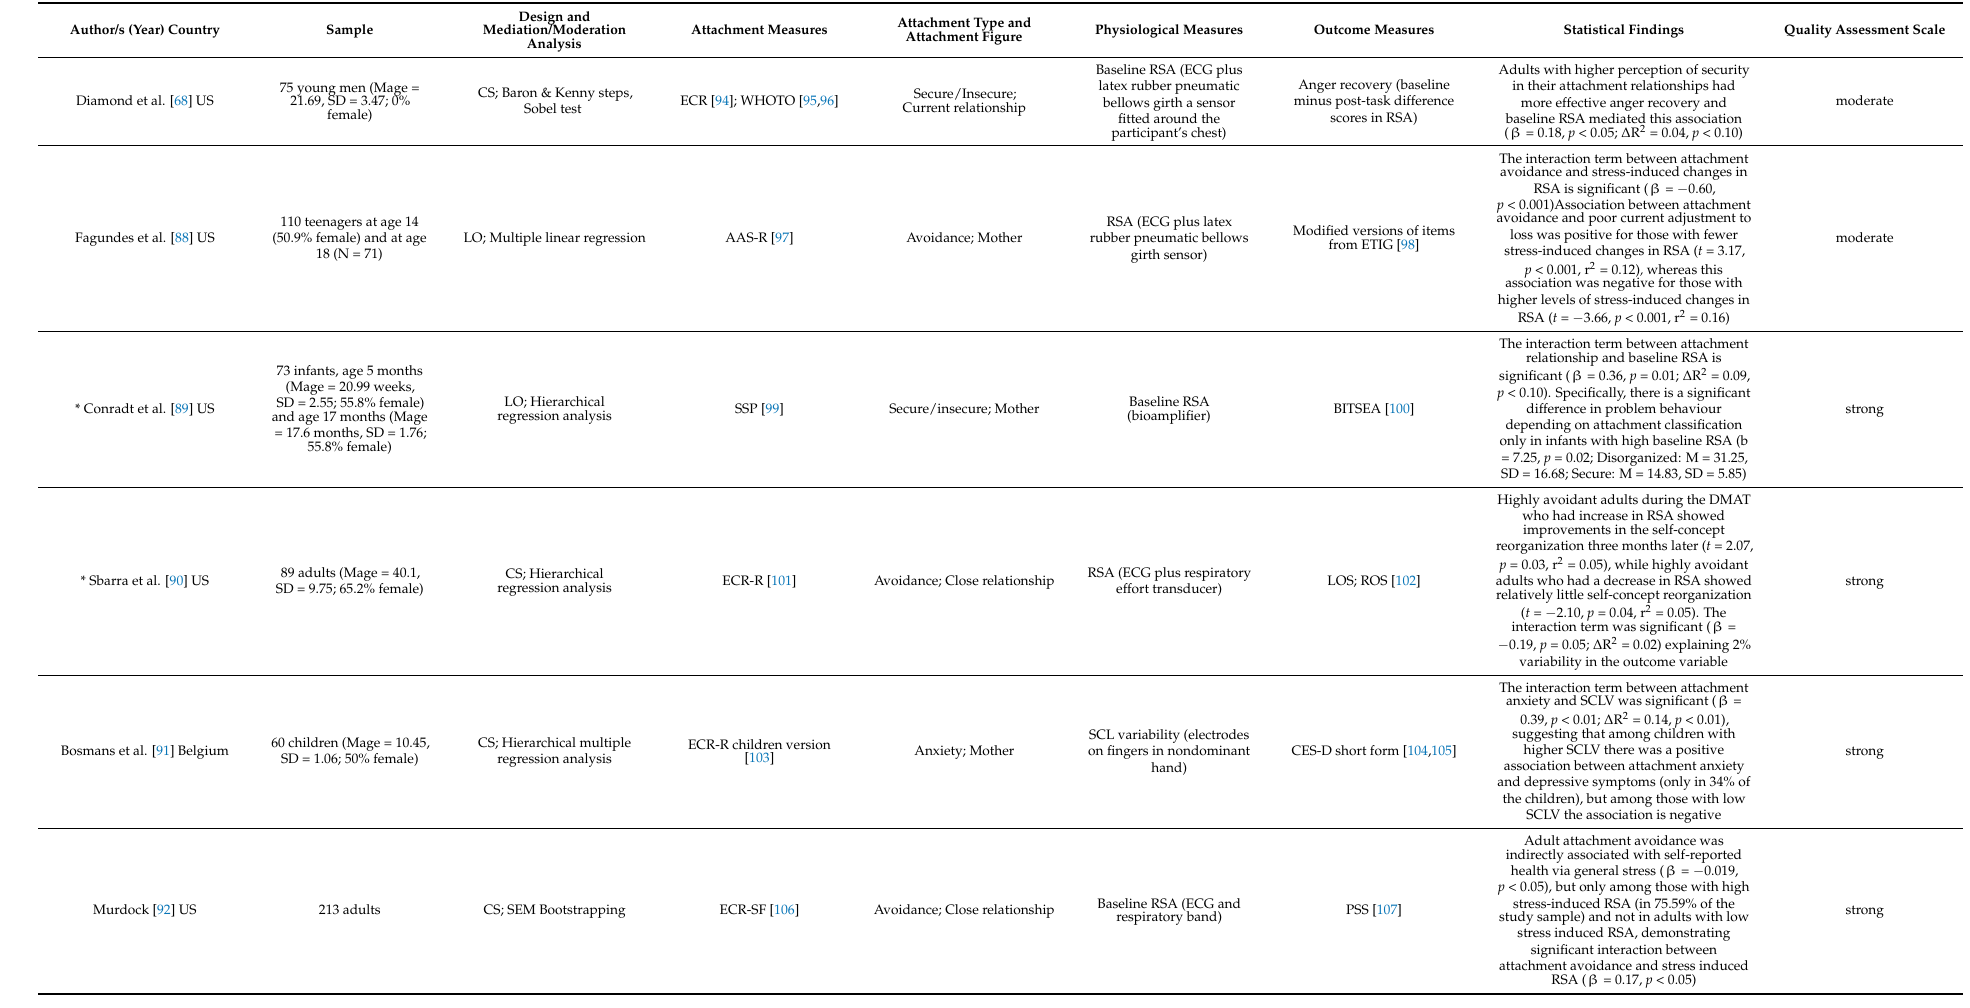
Table 4. Summary of reviewed